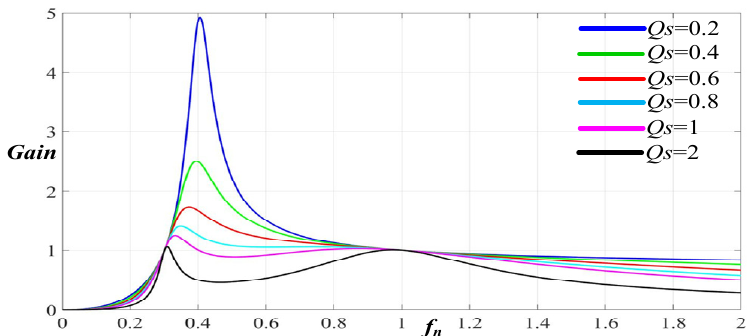
Figure 10. 2C3L resonant gains corresponding to different LLC Qs values.